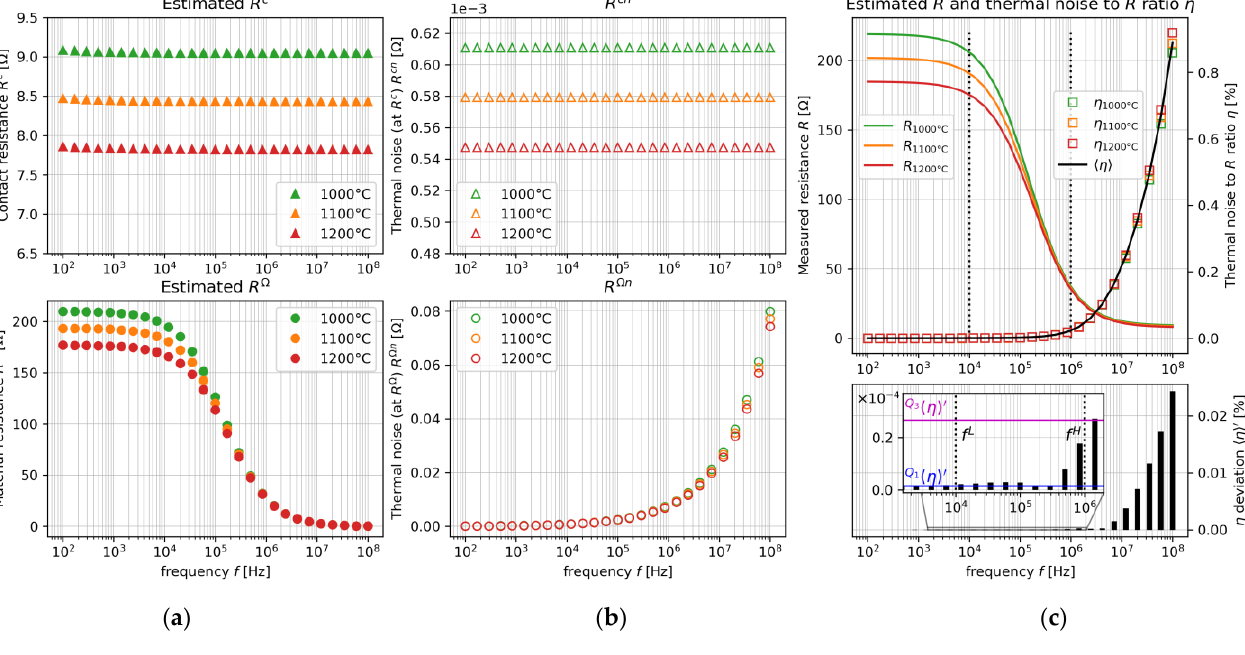
Figure 3. The plots of ( a ) estimated R c and R Ω , ( b ) thermal noise R cn and R Ωn , and ( c ) estimated R and thermal noise to R ratio, η .